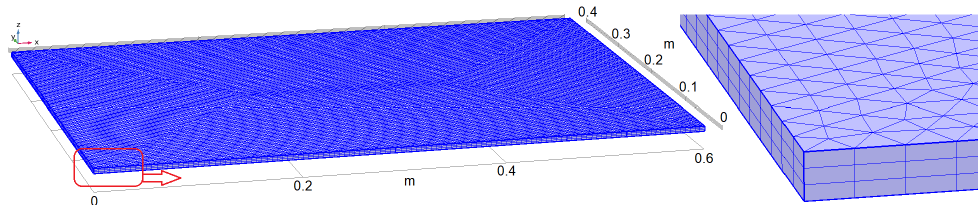
Figure 3. FE meshing of the preform volume.